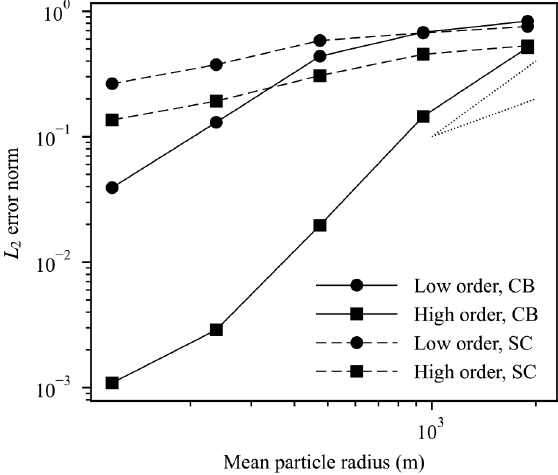
Figure 7. L 2 error norm versus mean particle radius for the cosine bell (CB) and slotted cylinder (SC) two-dimensional test cases with both low- and higher-order remapping. First- and second-order con- vergence gradients are also shown as the dotted